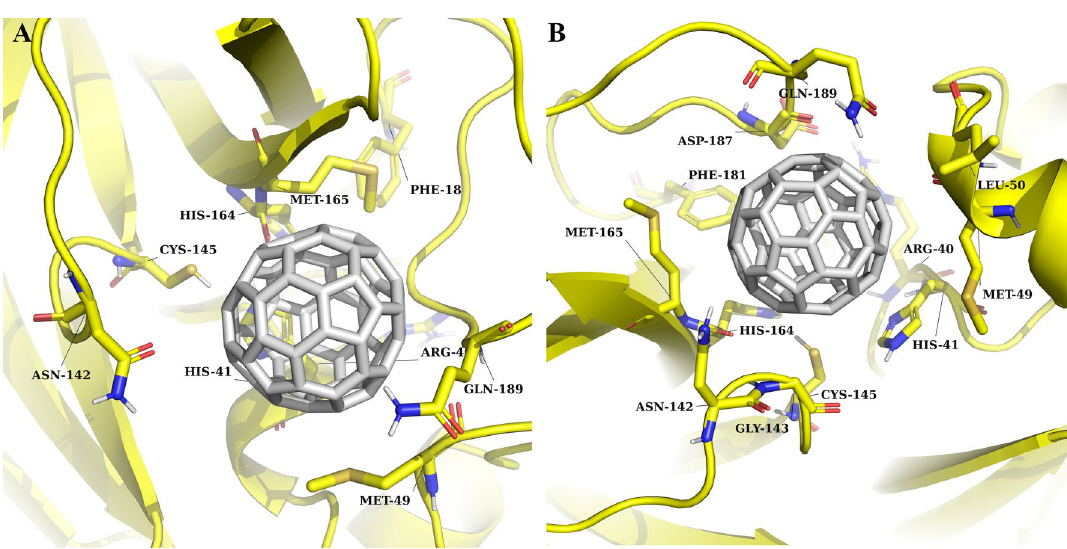
Figure 3. Catalytic binding pocket of 3CLpro: 3CLpro highlighted in yellow, and C 60 fullerene in grey. Molecular docking result ( A ); MD simulation result ( B